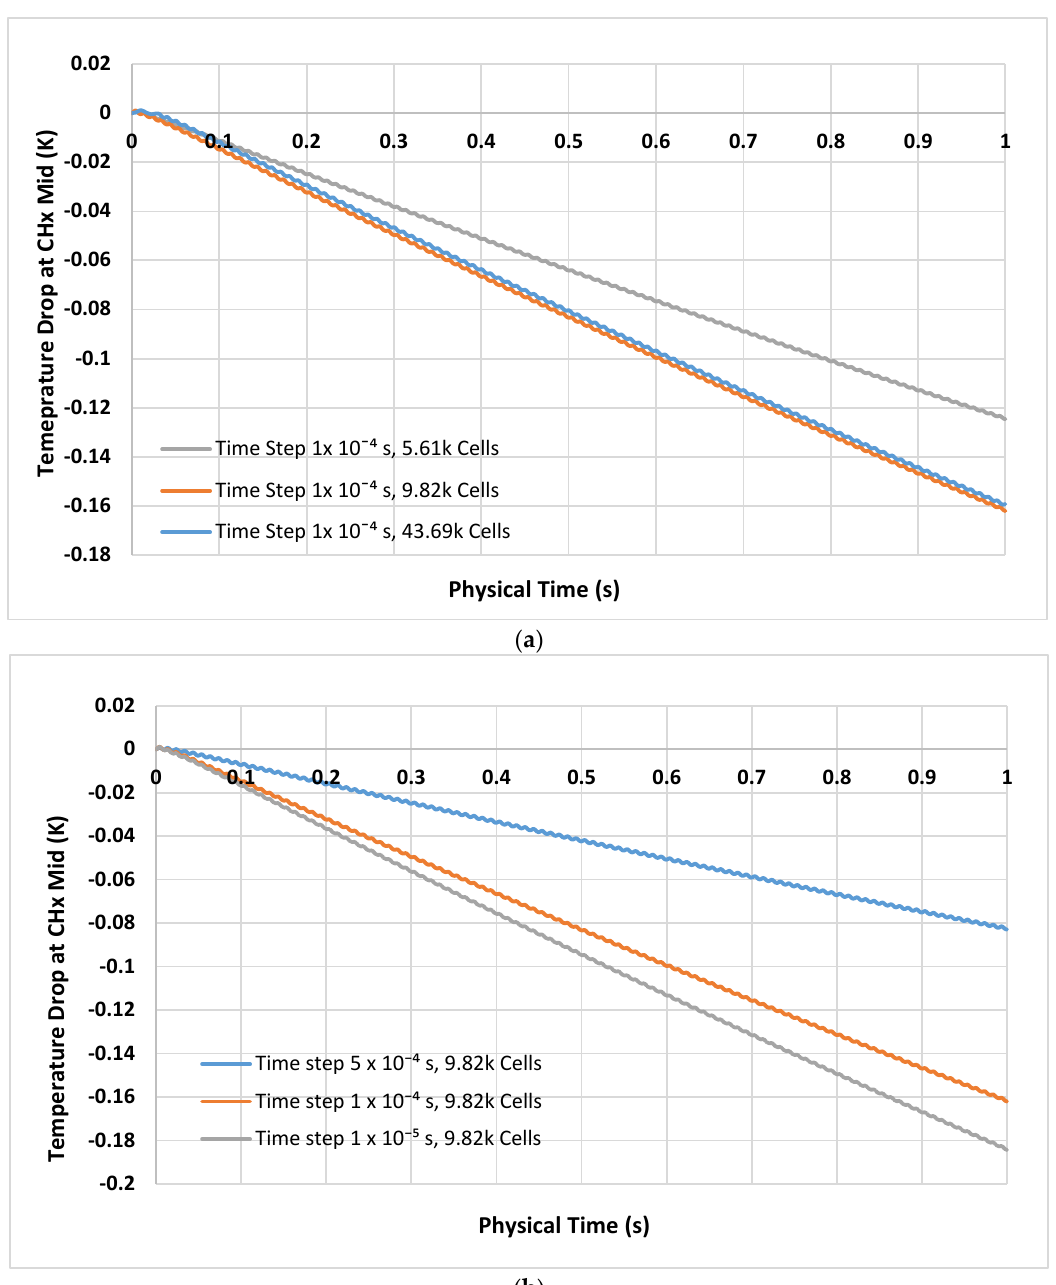
Figure 2. Mesh independence study with respect to ( a ) grid spacing ( b ) time increment.